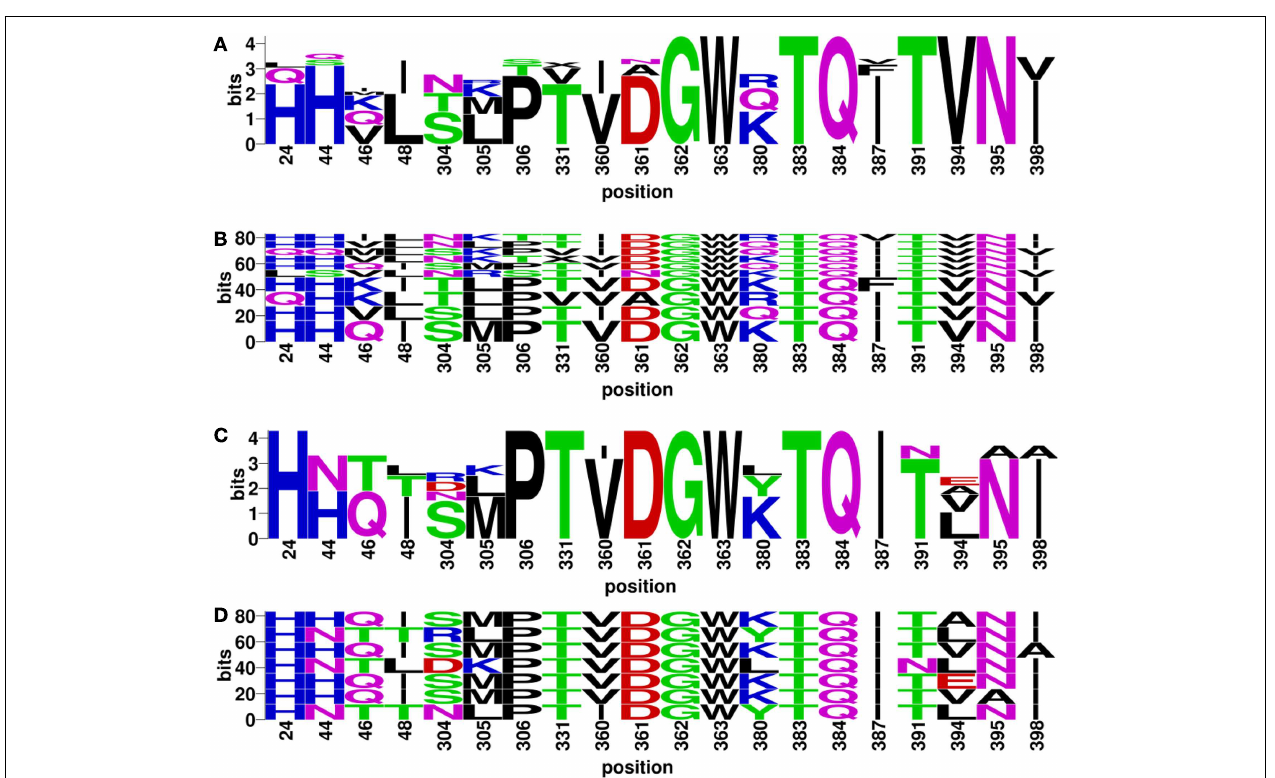
discontinuous motif extracted from the structure (PDB ID: 3FKU, chain A and B), corresponds to the positions of reference sequence [FLU0293715, A/Viet Nam/1203/2004(H5N1)]: 24, 44, 46, 48, 304, 305, 306, 331, 360, 361, 362, 363, 380, 383, 384, 387, 391, 394, 395, and